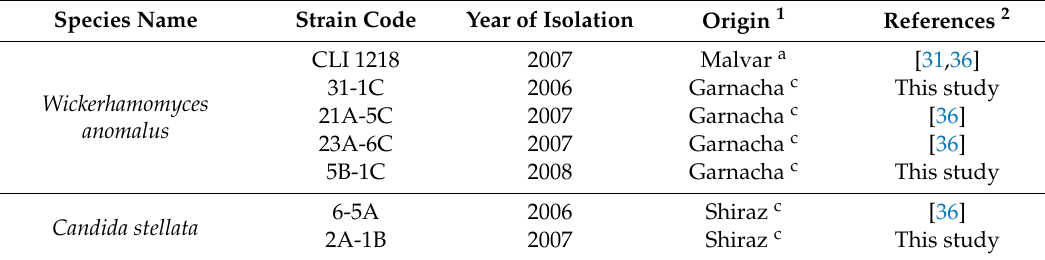
Table 1. Yeast strains used in this